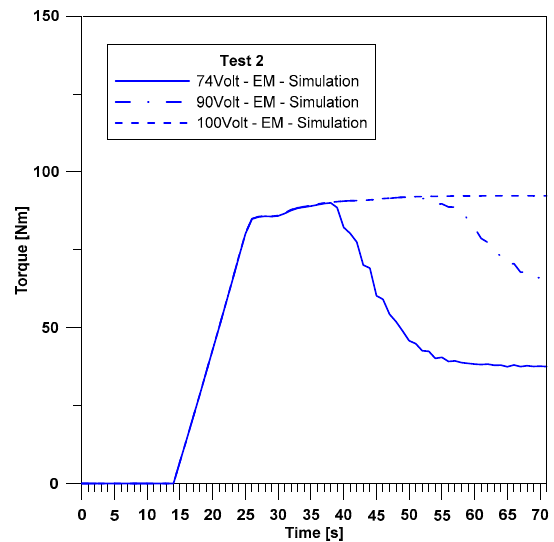
Figure 11. Comparison between calculated torque curves based on test 2: battery voltage of 74 V, 90 V, 100 V.